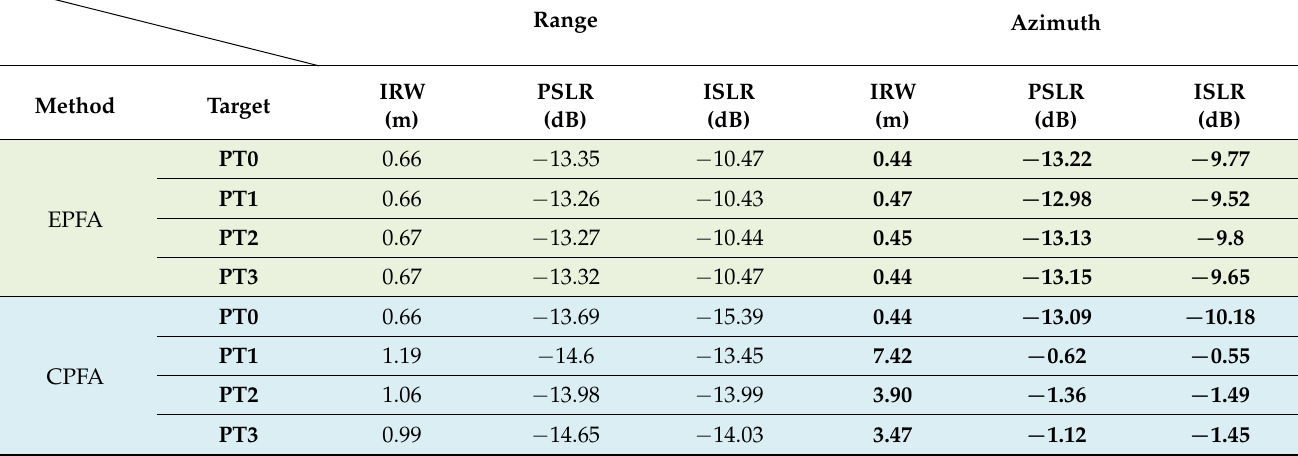
Figure 9. 2-D IRF of targets by EPFA. ( a ) PT0; ( b ) PT1; ( c ) PT2; ( d ) PT3. Table 2. Image quality